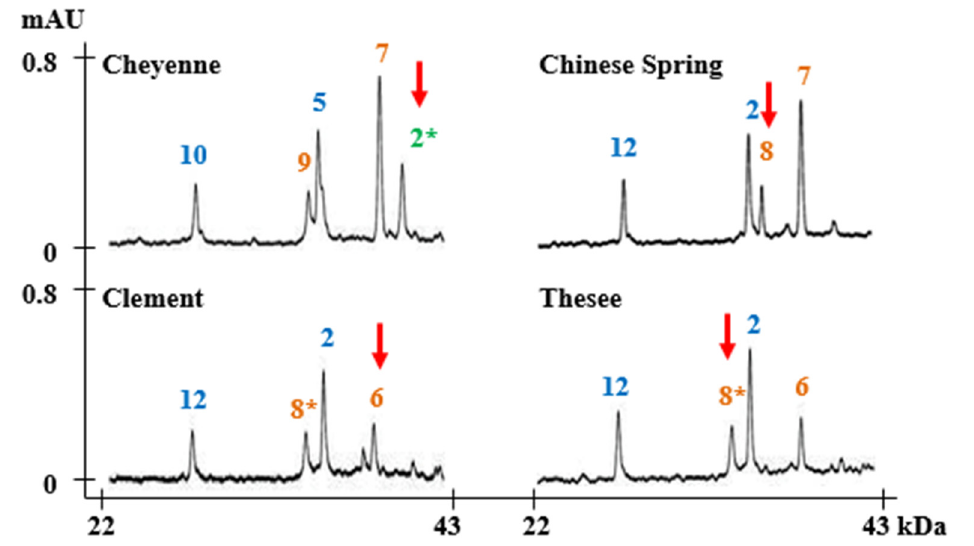
Figure 5. RP-HPLC analysis of subunits that could not be distinguished by MALDI-TOF-MS. Subunits corresponding to chromosomes 1A, 1B, and 1D are displayed in green, orange, and blue, respectively. Unidentified subunits 1Ax2*, 1Bx6 and 1Bx8, and 1Bx8* are indicated with red arrows.